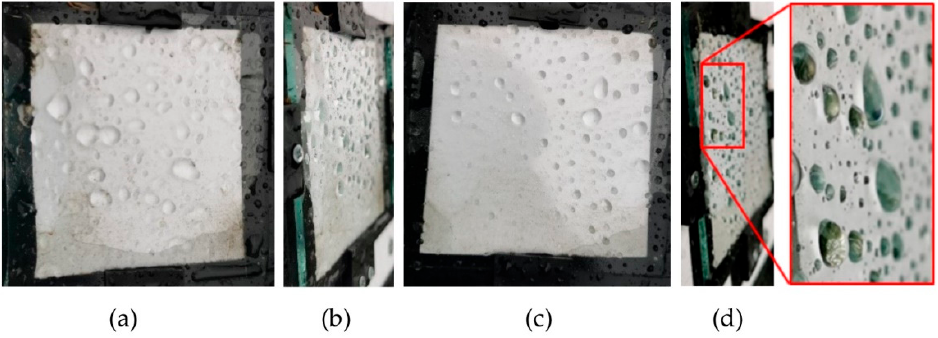
Figure 10. Droplet retention on coated A coupon at week 12.6 for uncleaned ( a ) planar view and ( b ) side view and for cleaned ( c ) planar view and ( d ) side view with close-up.